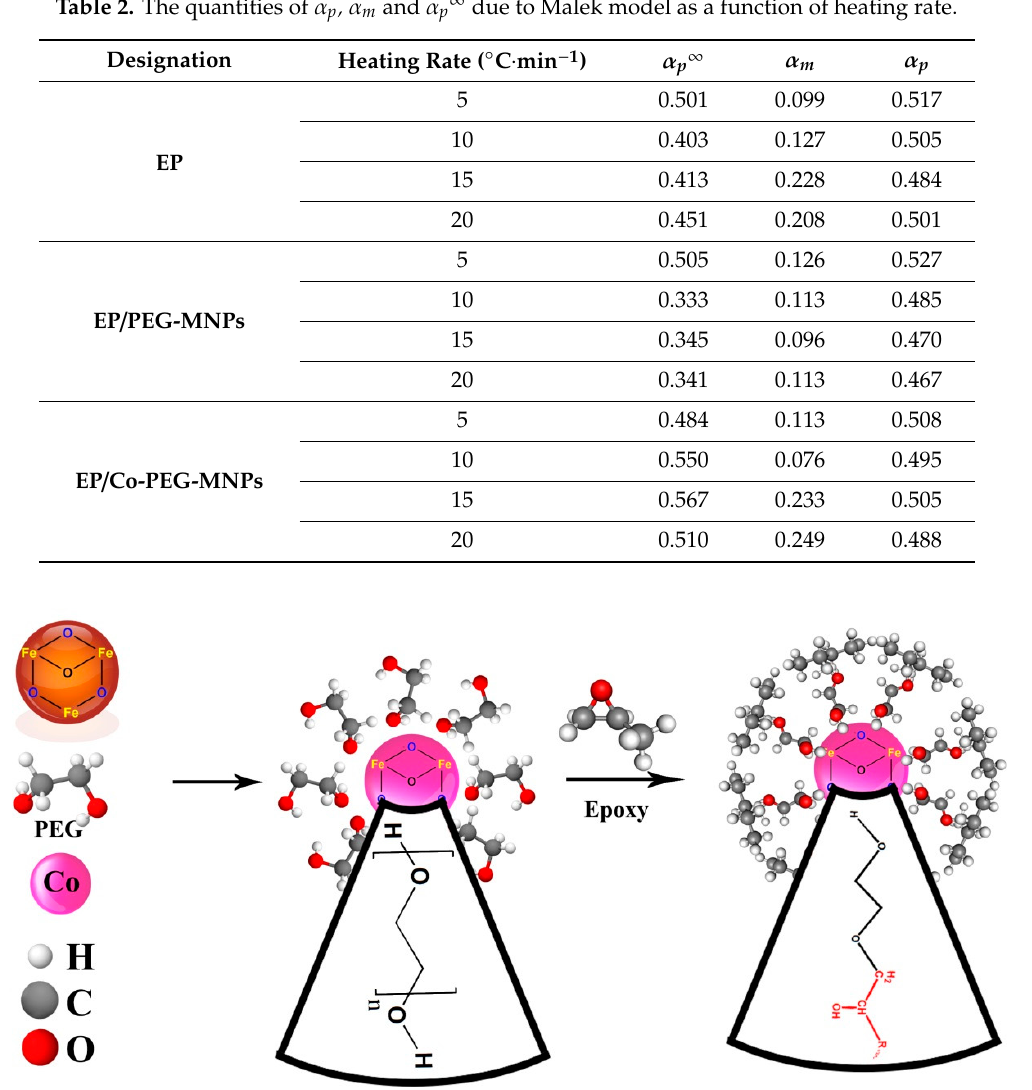
Figure 8. Possible reaction taking place between the PEG-Co-doped MNPs and the epoxy resin.